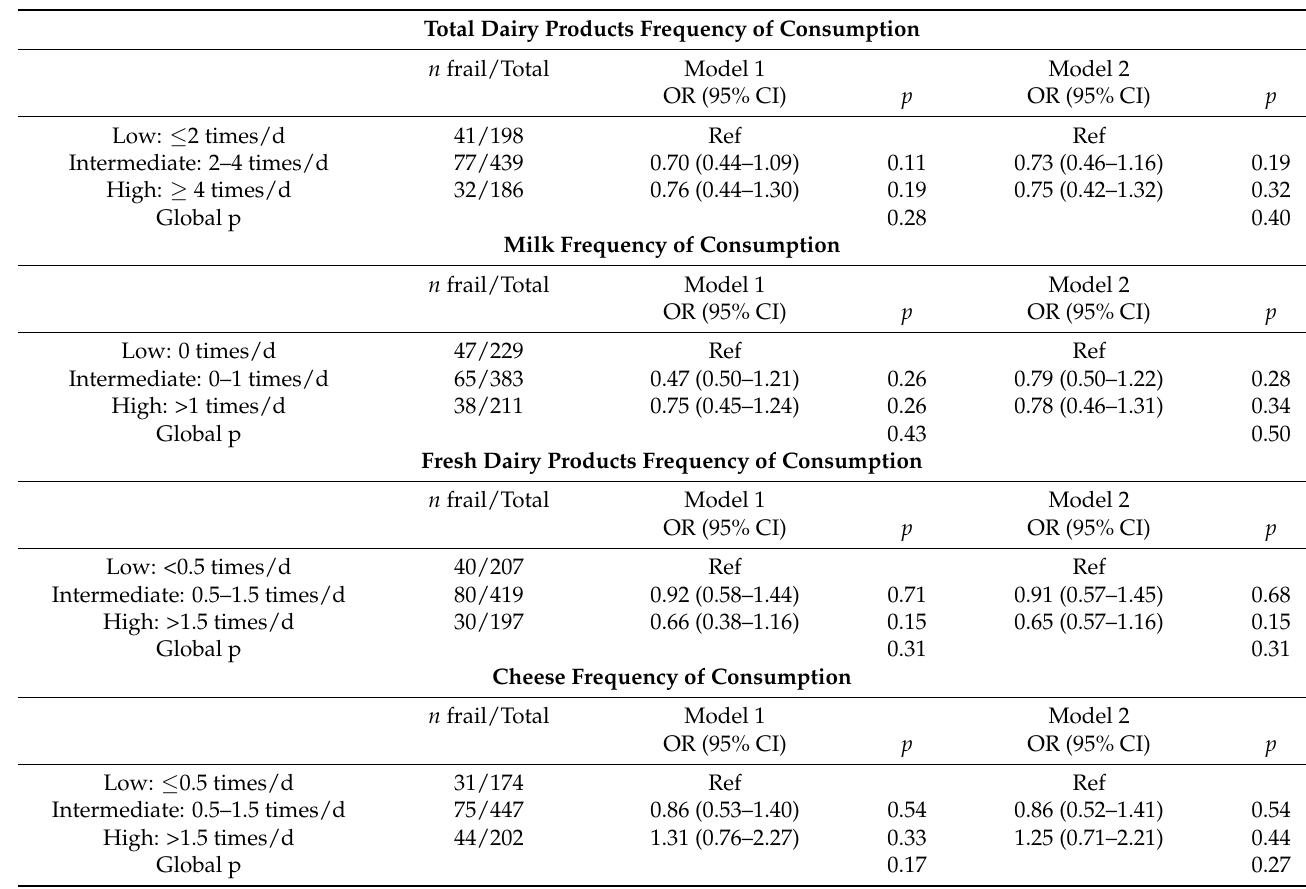
Table 4. Multivariate association between baseline frequencies of consumption of total DP, milk, fresh DP, and cheese and the 10-year frailty risk among older adults in the Three-City Study, Bordeaux ( n = 823,